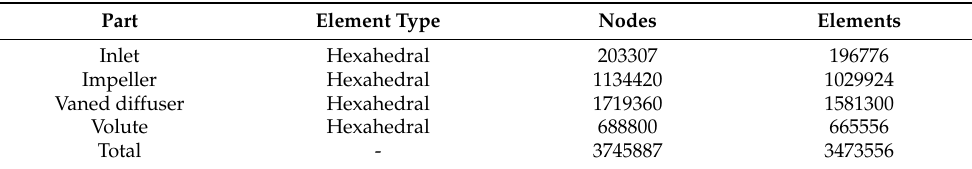
Table 4. Mesh number details of the computational domain.